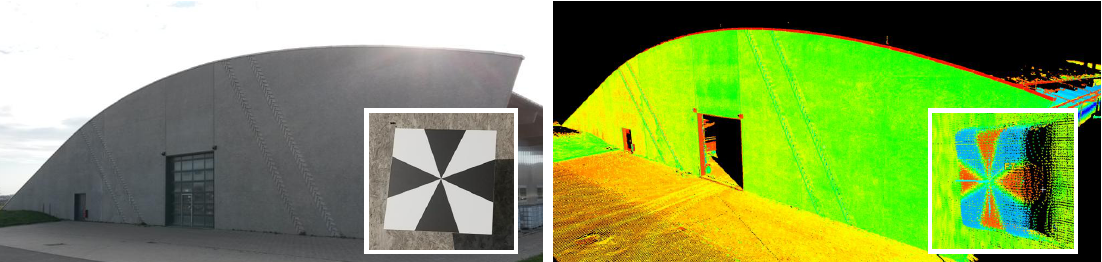
Figure 14. TLS (Terrestrial Laser Scanning) reference point clouds georeferenced using the control points and BOTA8 (Bonn Target 8) laser scanning